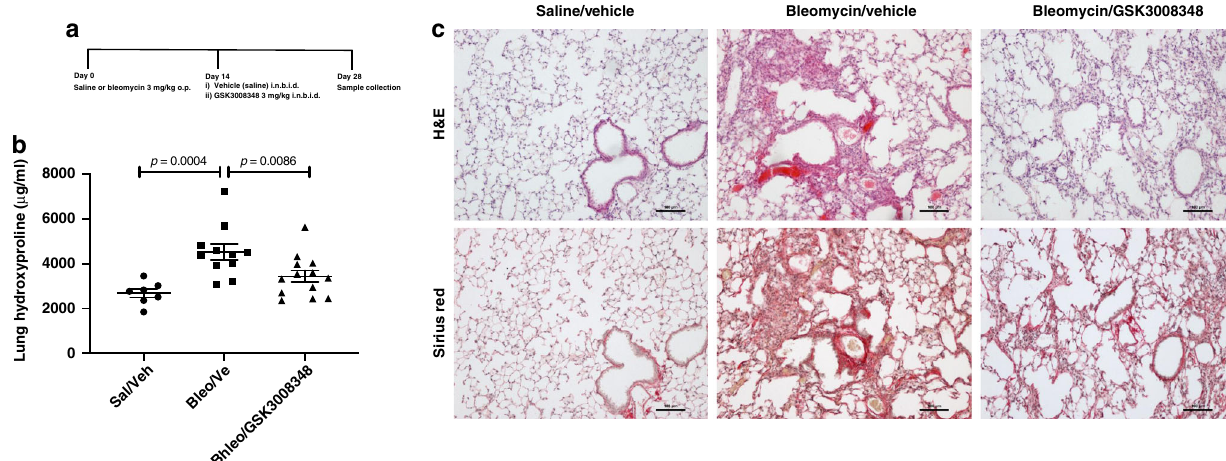
Fig. 7 Effect of therapeutic dosing with GSK3008348 on lung collagen. a Therapeutic dosing protocol. b Levels of collagen biomarker hydroxyproline in lung tissue from saline or bleomycin-treated mice in response to i.n. dosing with vehicle or GSK3008348 (mean ± SEM; n = 7 – 13 animals per group). c H&E and Sirius Red staining in representative lung sections from saline or bleomycin-treated mice ( n = 4 animals per group). Scale bars are 100 µ m. Statistical analysis completed by ANOVA with Fisher ’ s LSD post test. b.i.d., twice daily; Sal/Veh Saline/Vehicle, Bleo/Veh Bleomycin/Vehicle. Source data are provided as a Source Data fi